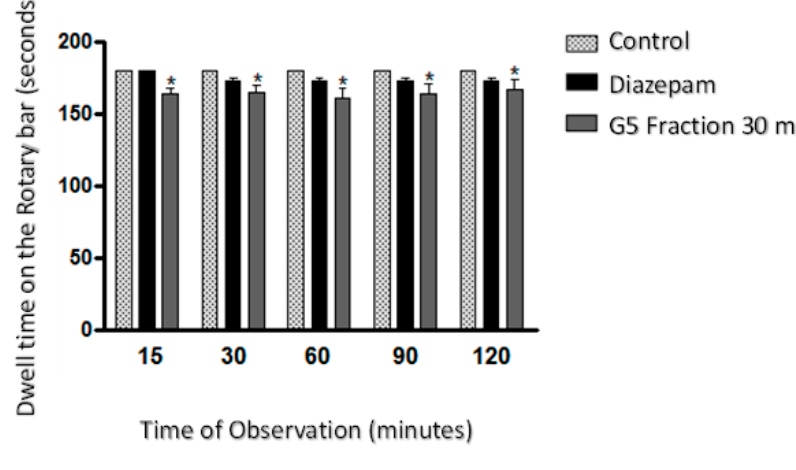
Figure 4. Effects of the G5 fraction (30 mg/kg) Schinus terebinthifolius Raddi fruit extract on Swiss mice ( Mus musculus ) in the Rotarod test. The values are expressed as means ± SEM of ten experiments. One-way ANOVA followed by Newman-Keuls test (* p < 0.05 compared to the control). Treatment with G5 produced hypolocomotion, increased immobility and muscular